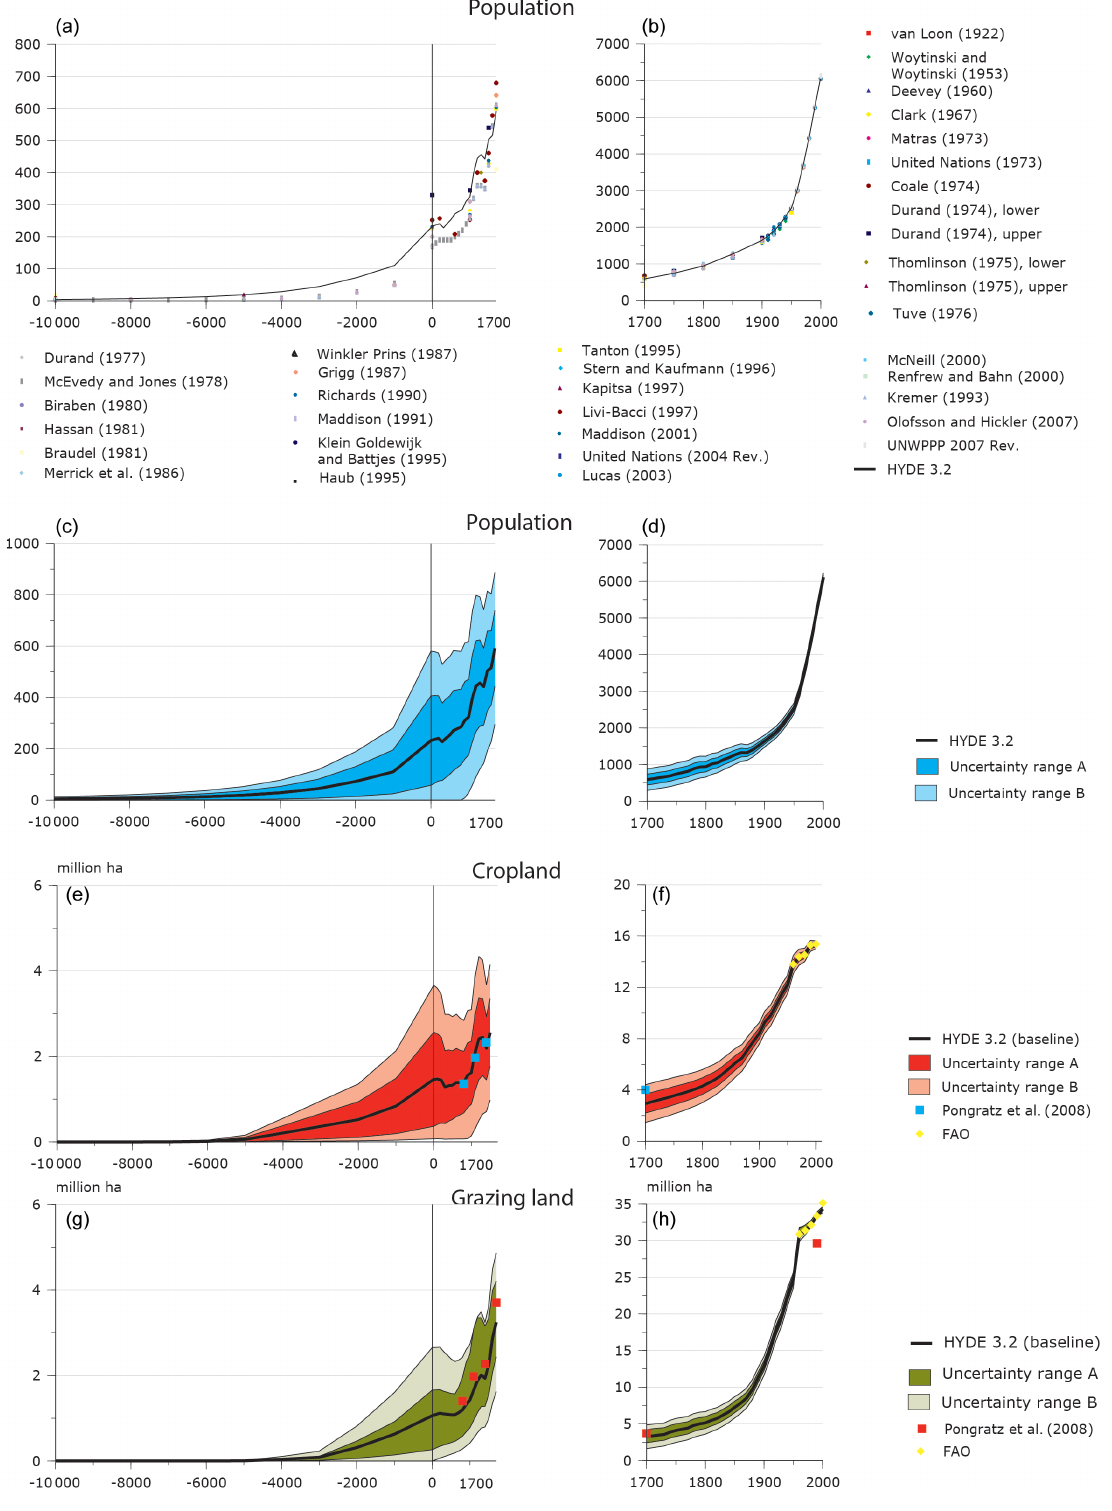
Figure 9. Available sources for population estimates (a, b) , and uncertainty ranges for global population (c, d) , cropland (e, f) and grazing land (g, h) , split into recent past (1700CE onwards) and before 1700CE to allow for different scales.